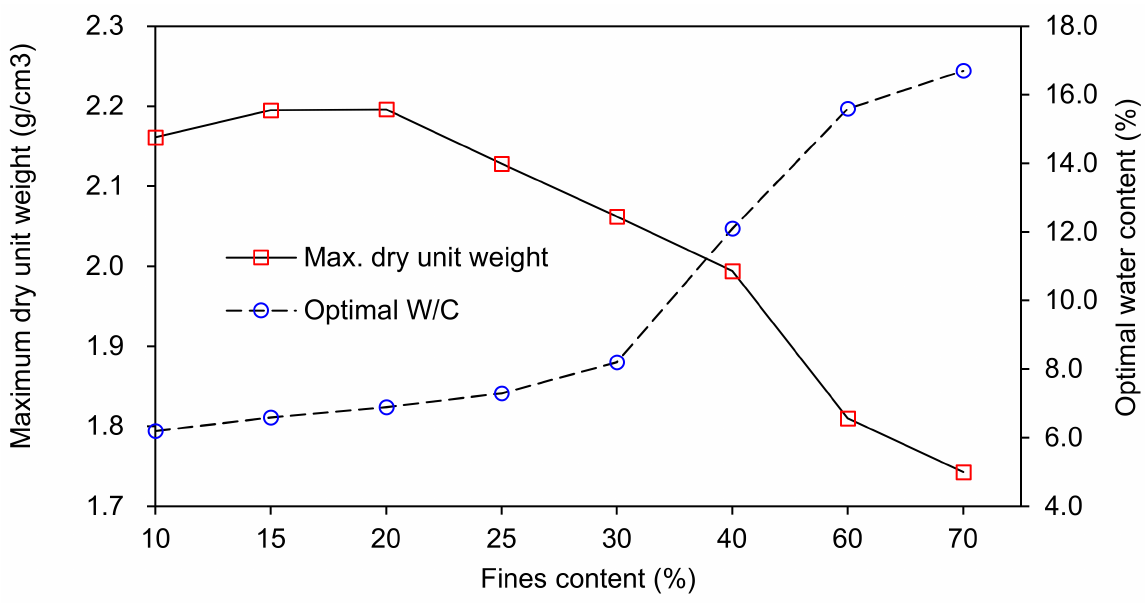
Figure 5. Maximum dry unit weight and optimal water content in various fines